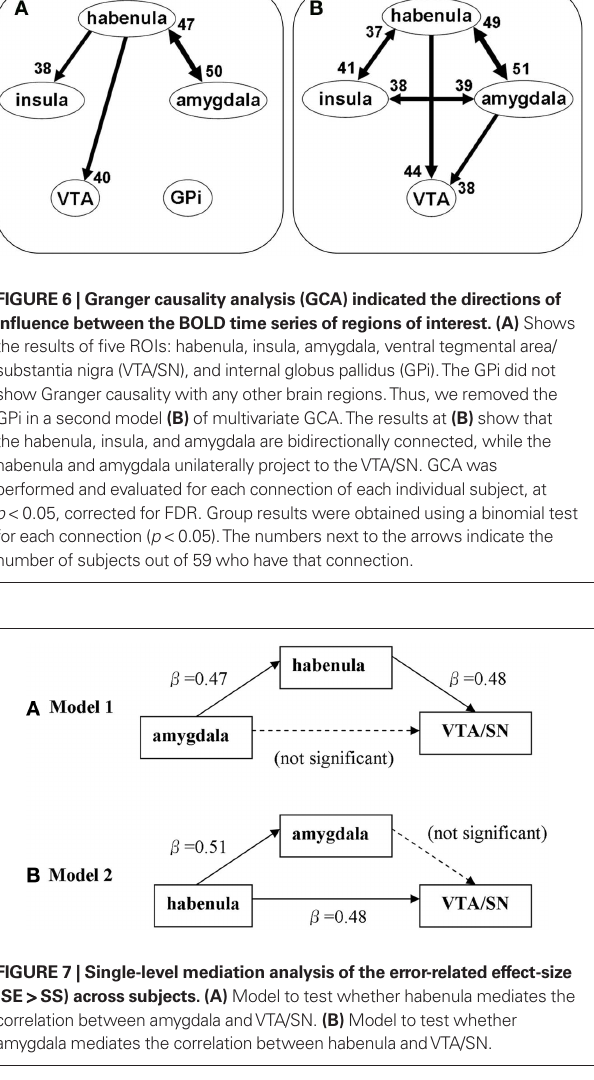
Table 4 | Mediation analysis results between amygdala, habenula, and VTA/SN.